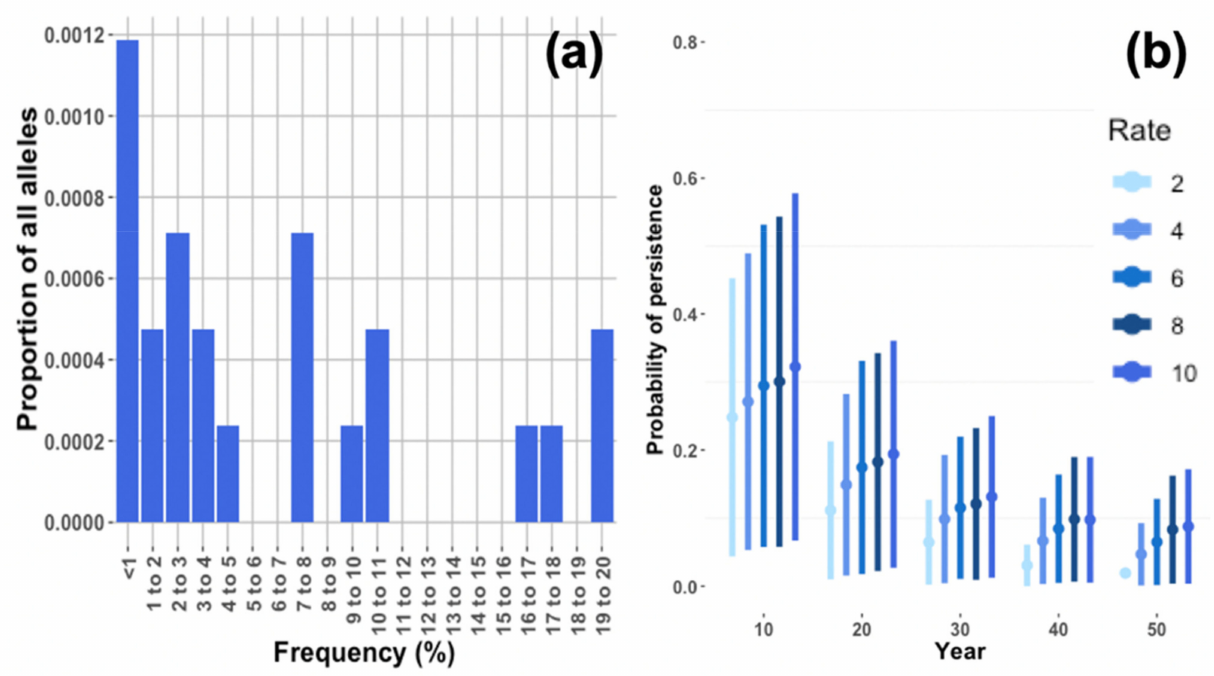
Figure 5. ( a ) Frequency distribution of locally unique alleles in the lowland population in 2019. Counts of alleles are expressed as a proportion of all alleles in the dataset ( n = 4218). Frequencies of locally unique alleles from 2011 to 2019 are shown in Supplementary Figure S3. ( b ) Mean ± 1 SD retention probability for locally unique alleles of any initial frequency during 50 years of simulated genetic rescue. Simulations began with 20 Yellingbo individuals, supplemented with different numbers of highland individuals per year (Rate). Probability and frequency values were output every ten years, with values calculated from 200 replicate runs of each scenario. A carrying capacity of 1000 was